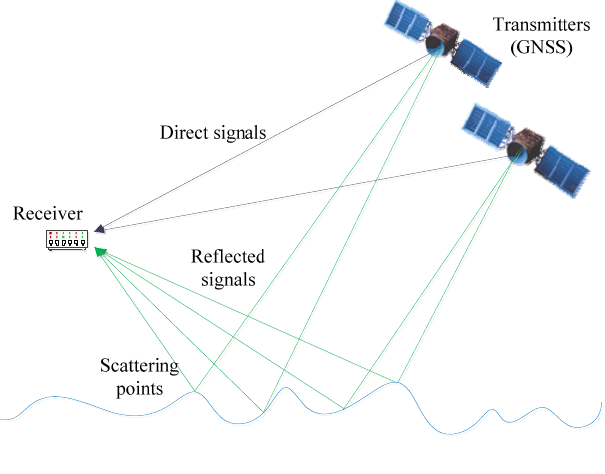
Figure 1. Geometry of